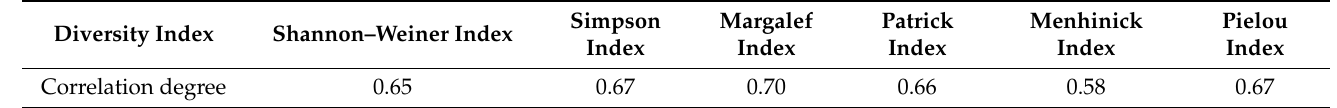
Table 1. Correlation degree between species diversity index and groundwater